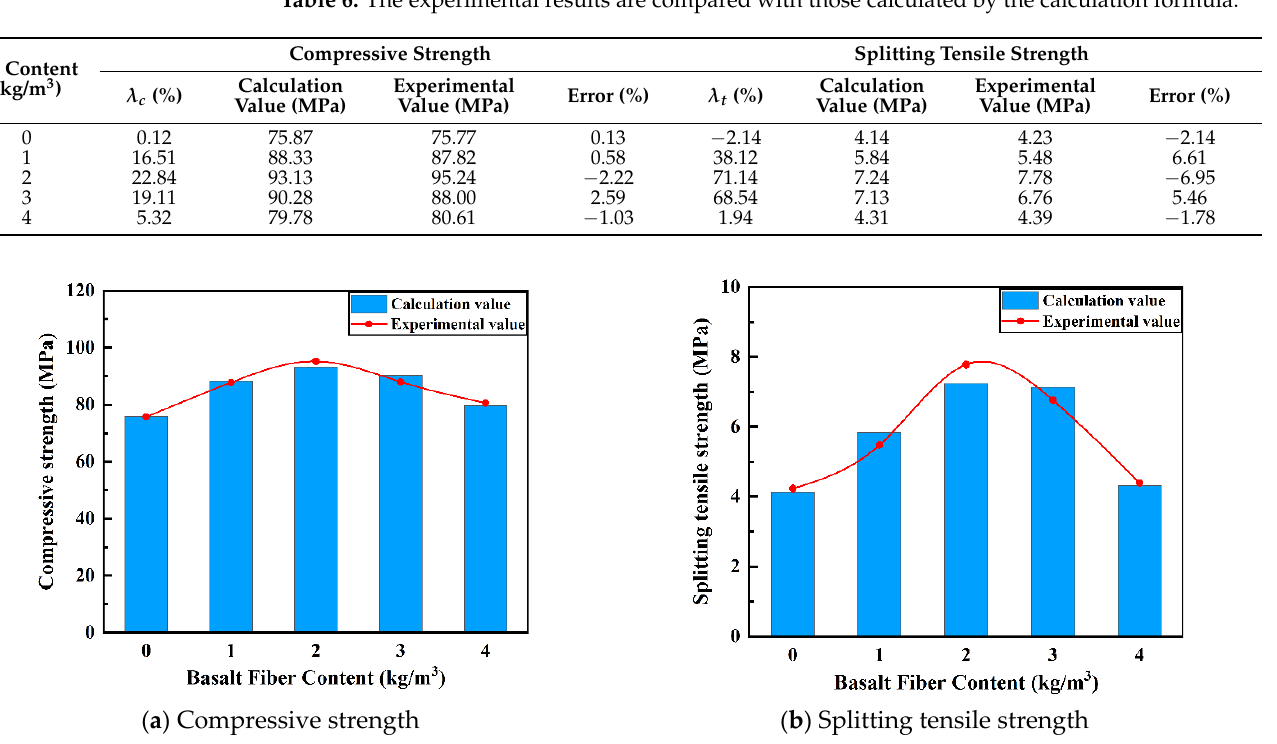
Figure 16. The experimental results are compared with those calculated by the calculation formula.